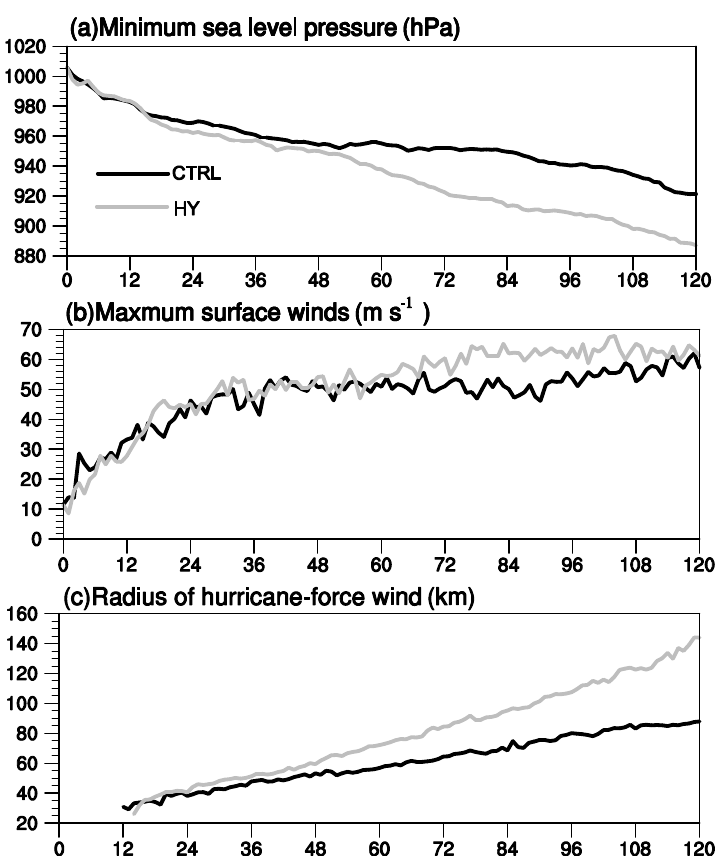
Figure 1. Time series of the ( a ) minimum sea level pressure (hPa), ( b ) azimuthally averaged maximum surface (the lowest model level) wind speeds (m s −1 ), and ( c ) azimuthally averaged radius of hurricane-force (33 m s −1 ) winds (km).